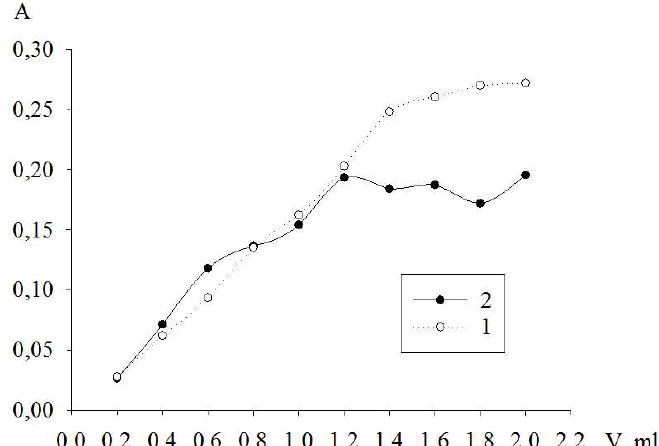
Fig. 4. Graph of the dependence of the amount of absorption on the composition of the isomolar solution: V1 – 0.001 M sotalol solution; V2 – 0.001 M solution diazole red 2J) at 380 nm